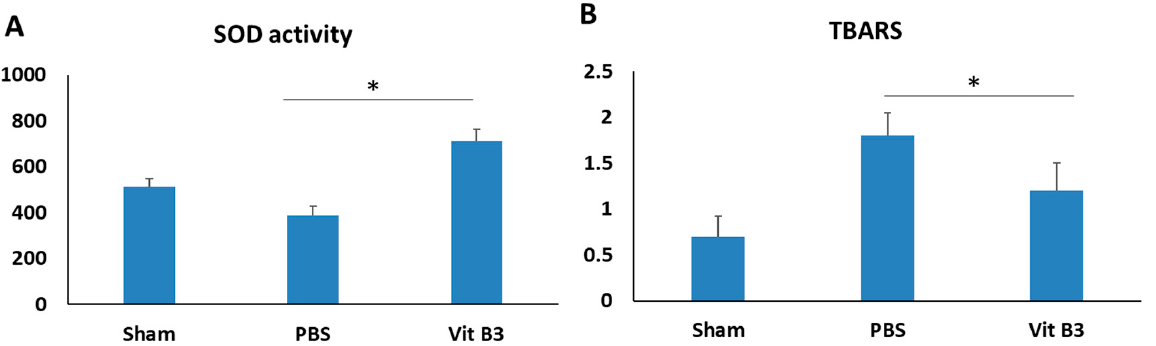
Figure 5. SOD activity and TBARS levels for oxidative stress were measured in the retina on day 7 following rAION induction. ( A ) In comparison to the PBS-treated group, the vitamin B3-treated group’s relative SOD activity was noticeably higher (* p < 0.05; n = 6 per group). ( B ) In comparison to the PBS-treated group, the relative TBARS in the vitamin B3-treated group was considerably lower (* p < 0.05; n = 6 per group). Data are expressed as the mean ±